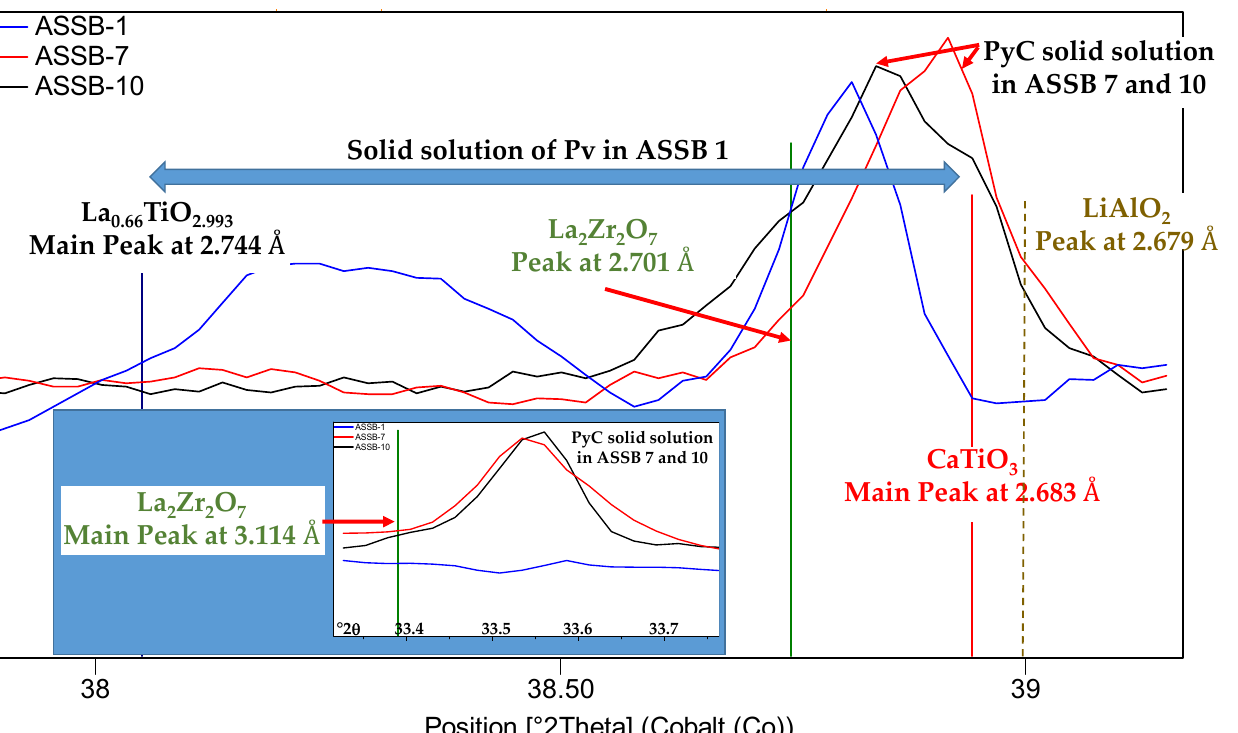
Figure 7. Section of PXRD measurements with the main peaks of La 0.66 TiO 2.993 , La 2 Zr 2 O 7 , CaTiO 3 , and LiAl (from left to right).